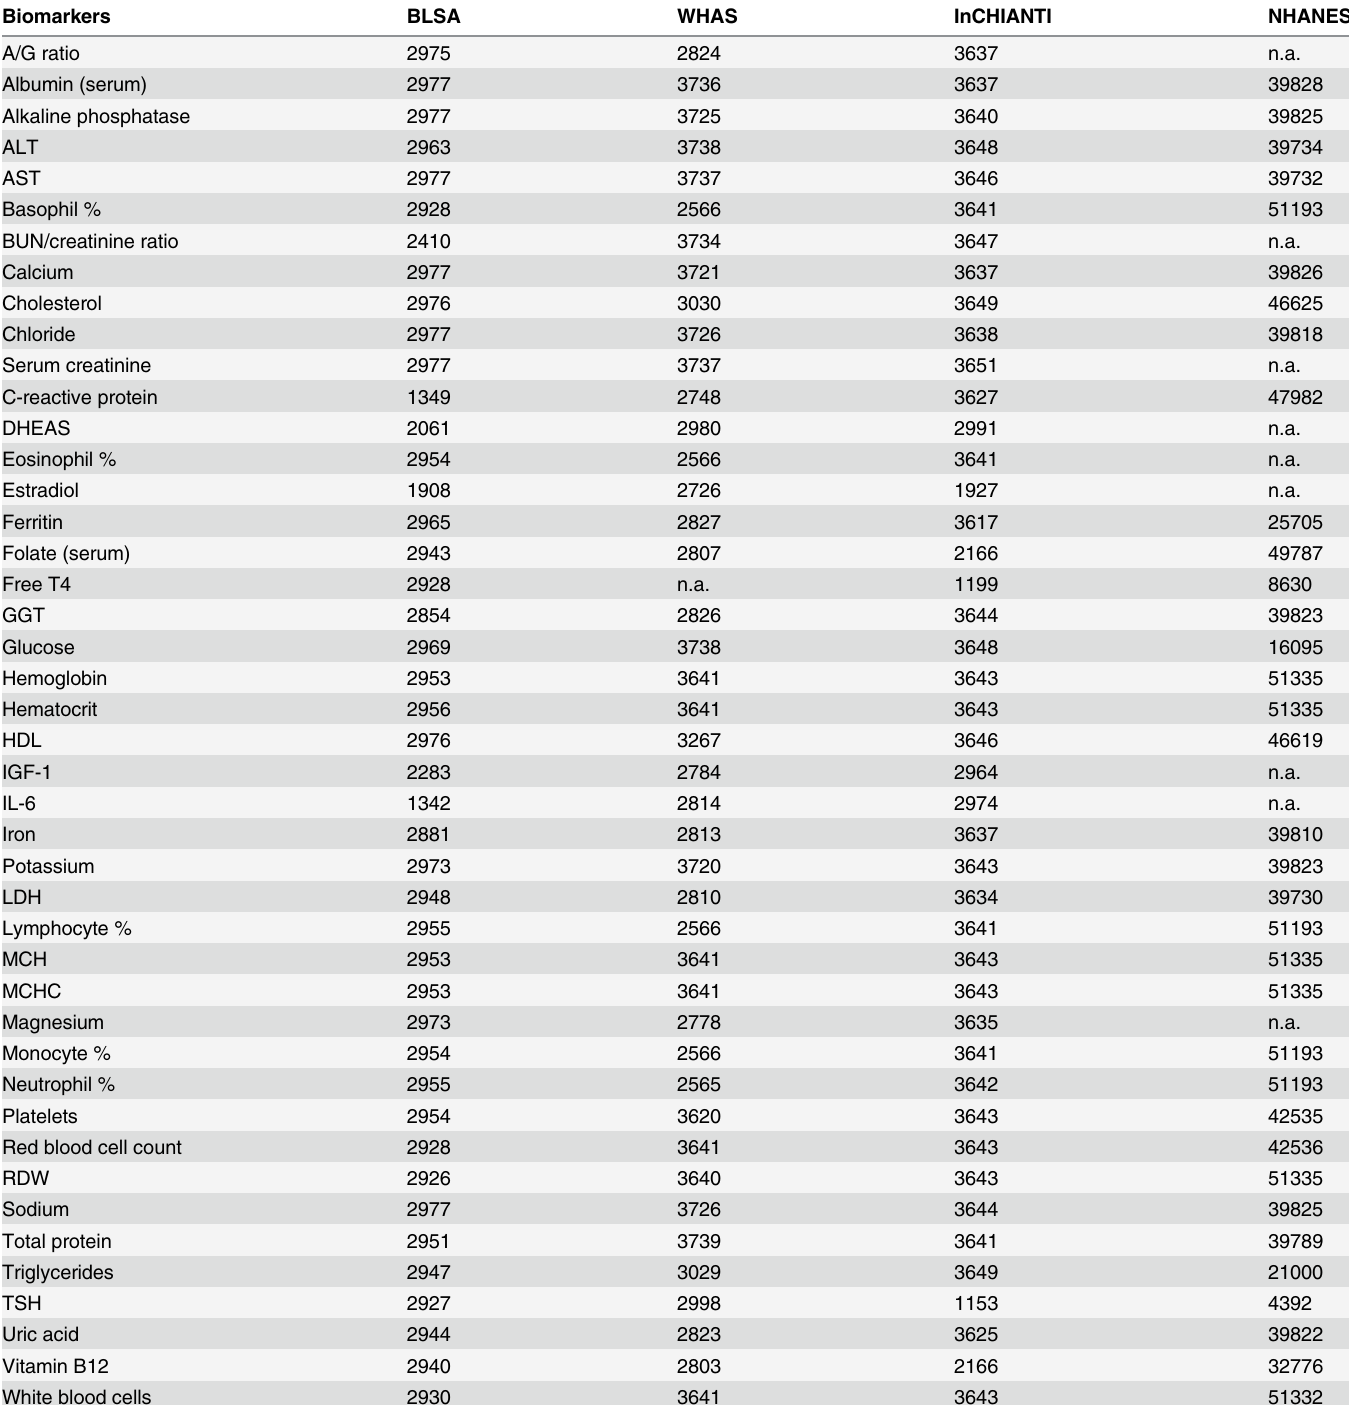
Table 1. Biomarkers used in this study and number of observations for each data